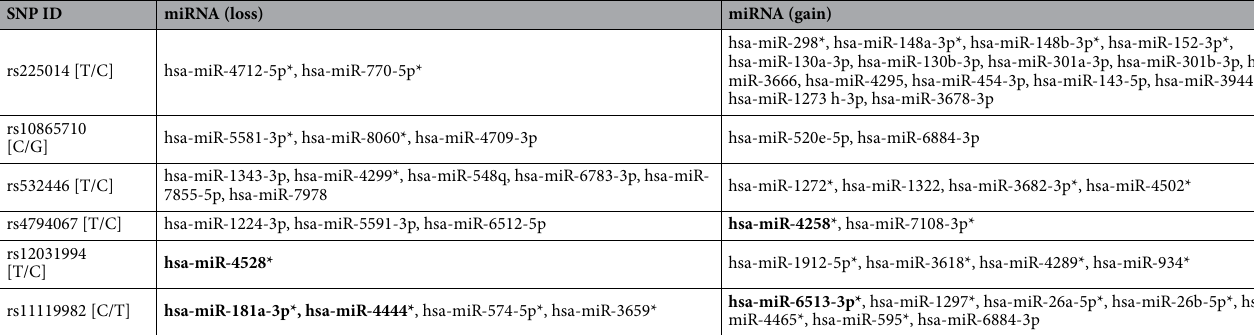
Table 9. Effect of SNPs on the binding of miRNA (gain or loss). * p values < 0.05; p values < 0.01 are marked in